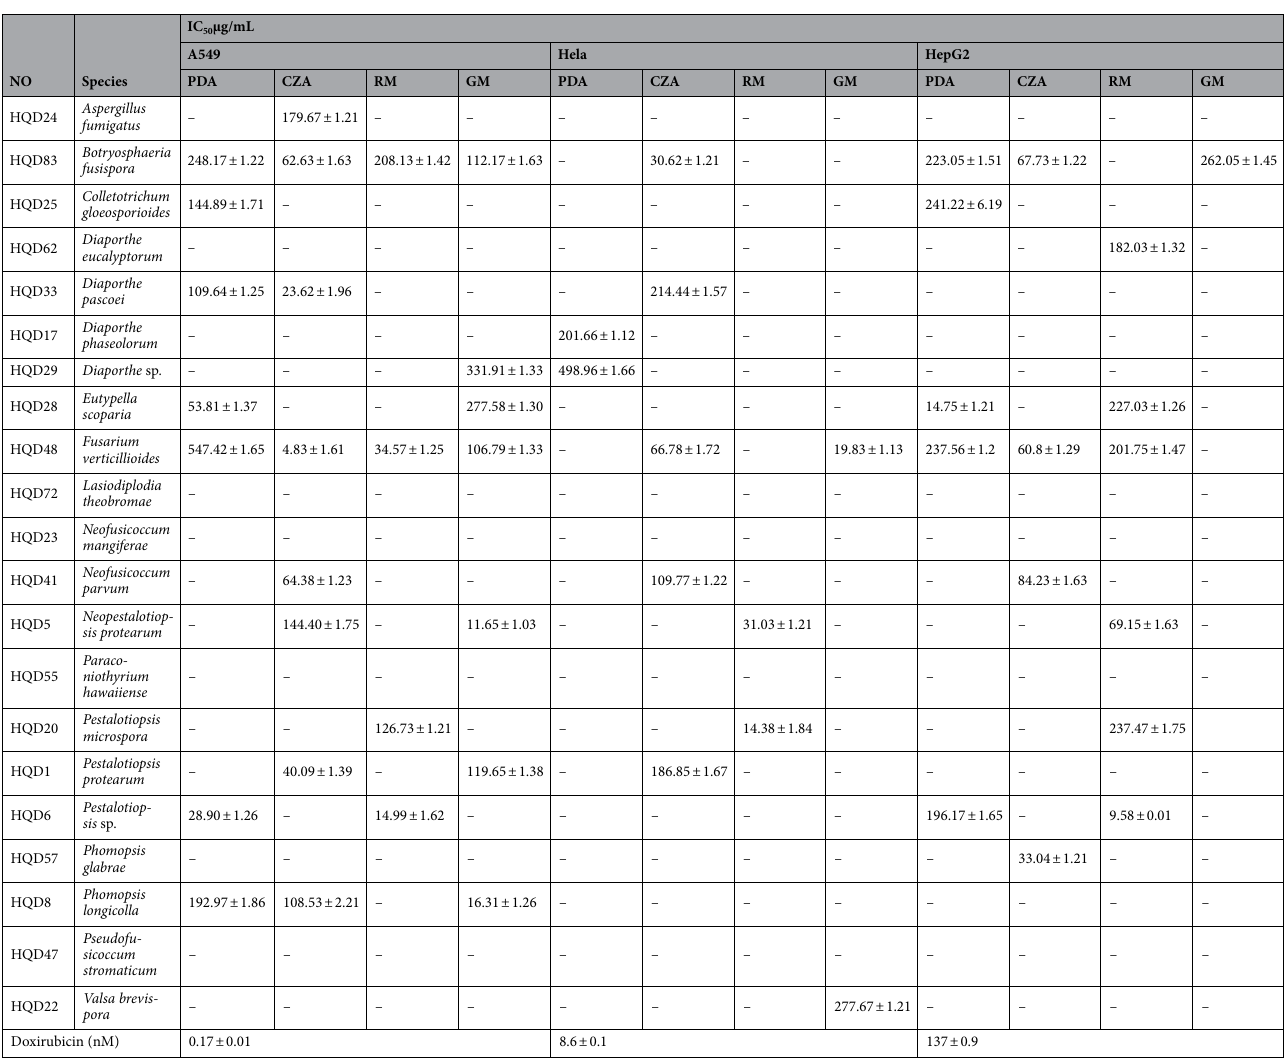
Table 4. Anti-tumor activity of endophytic fungi from R.